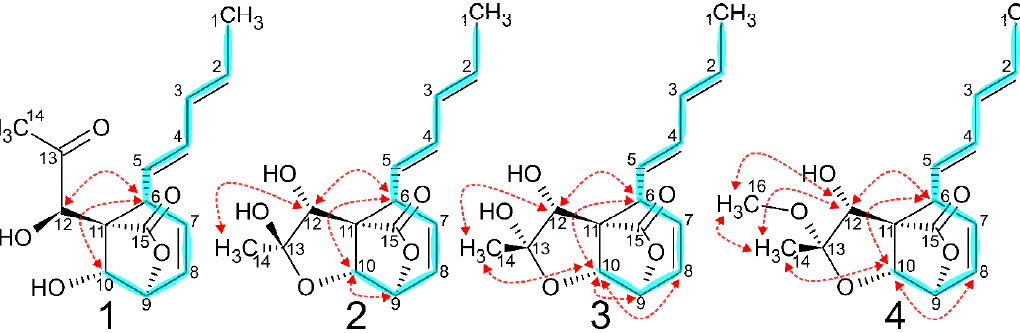
Figure 3. Homonuclear 2D NMR correlations of 1 – 4 showing TOCSY / COSY (blue) and NOESY / ROESY (red) correlations. TOCSY, COSY and NOESY was applied for 1 – 3 while COSY and ROESY was applied for 4 .